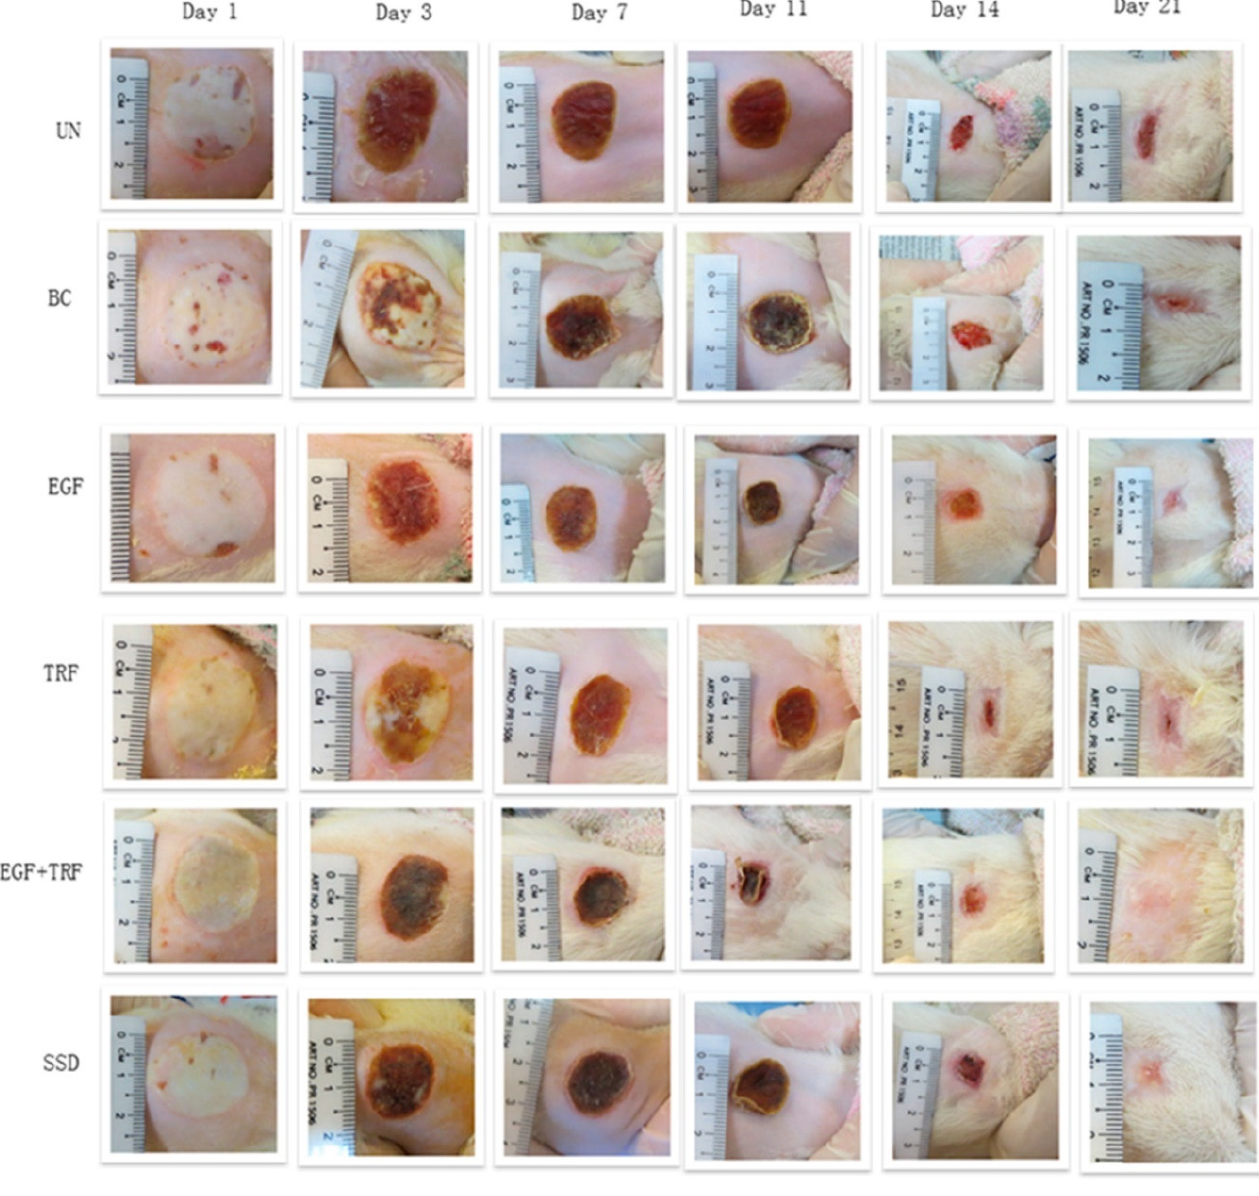
Figure 5. Wound closure of deep partial-thickness burn wounds over time in Sprague Dawley rats. (UN, without any treatment; BC, treated with base cream; Epidermal growth factor (EGF), treated with base cream containing c% EGF; Tocotrienol-rich fraction (TRF), treated with base cream containing 3% TRF; EGF + TRF, treated with base cream containing both c% EGF and 3% TRF; and SSD, treated with SSD cream) (adapted from [93], published by MDPI, 2020).